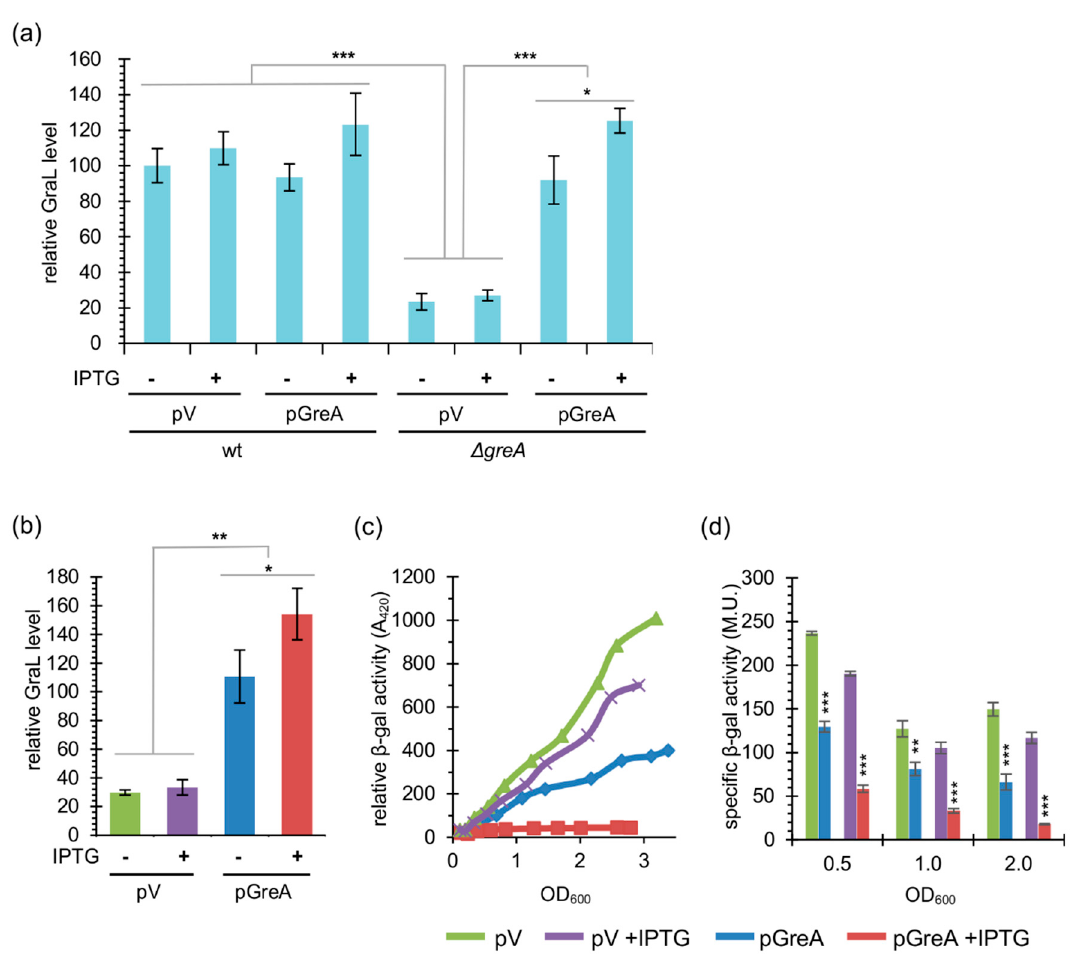
Figure 5. Increased GreA levels correlate with an increase in GraL abundance and a decrease in transcripts that are not terminated at the GraL terminator. ( a ) Relative GraL level was assessed by Northern blot analysis, as described in Figure 4. If present, IPTG was added to 1 mM at OD 600 ~ 0.1. Samples were taken from wt or Δ greA strains at OD 600 ~ 3.0. Data were normalized to wt/pV; this experiment was done in triplicate. ( b ) Same as in ( a ) but with the Δ lacZ Δ greA Δ GraL strain carrying the UP lac - plac UV5 - greA-lacZ fusion; data were normalized to the pGreA sample; experiment was done in triplicate. ( c ) A representative differential plot of β -galactosidase activities of the strain used in ( b ). ( d ) Specific β -galactosidase activities at OD 600 ~ 0.5, 1.0, and 2.0 of the strains presented in ( b ) and ( c ); this experiment was done in triplicate. Error bars represent SD. For clarity, p -values calculated only for pV vs . pGreA, and pV+IPTG vs . pGreA+IPTG are shown in ( d ). * p < 0.05, ** p < 0.005, *** p < 0.0005.